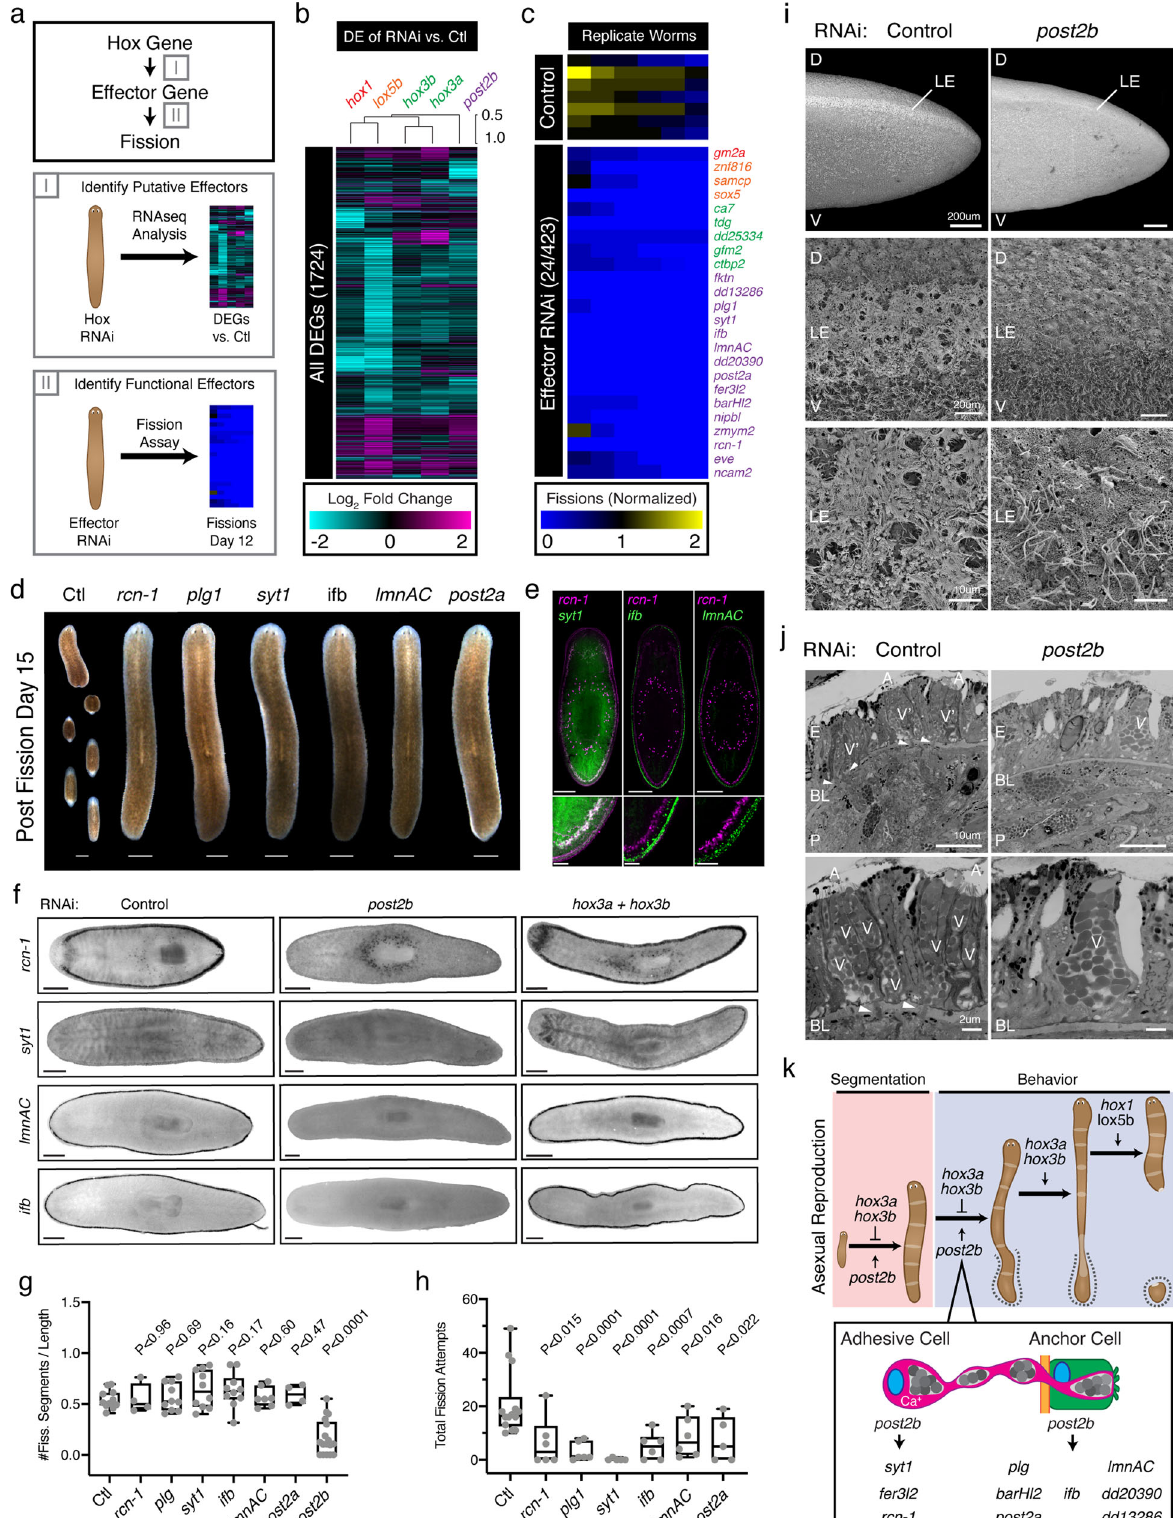
Role of post2b and effectors in the MAG . Our screening analysis identi fi ed multiple Hox gene effectors required for asexual reproduction (Fig. 4). ScRNAseq analysis and WISH staining indicate that the effectors required for fi ssion are expressed within multiple cell populations in the adult animal 29 (Fig.